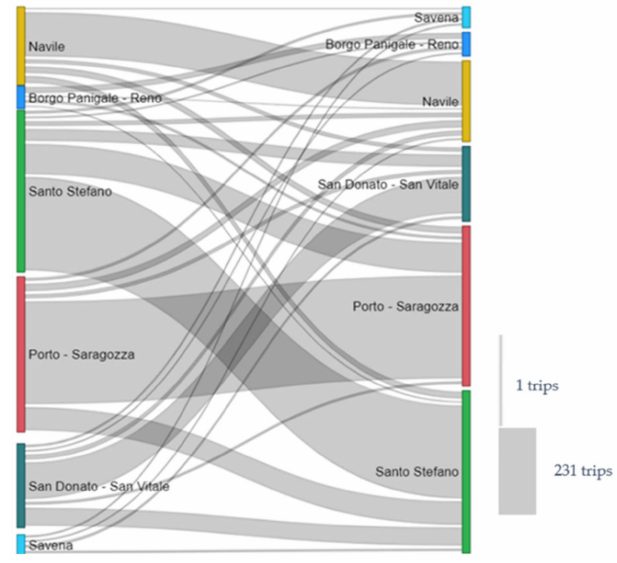
Figure 7. O/D matrix flows (color ramp is consistent with Figure